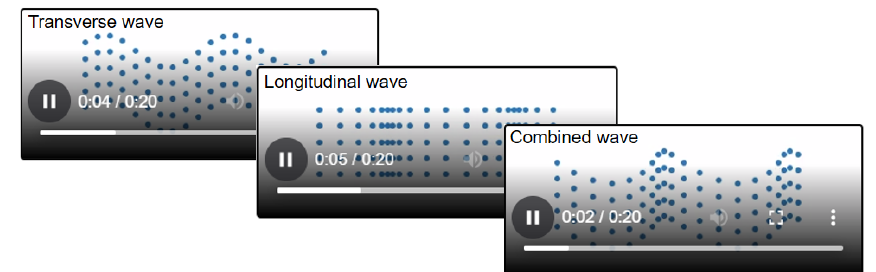
Figure 6. Videos generated by the FMP Notebook Waves and Waveforms to illustrate the concepts of transverse, longitudinal, and combined